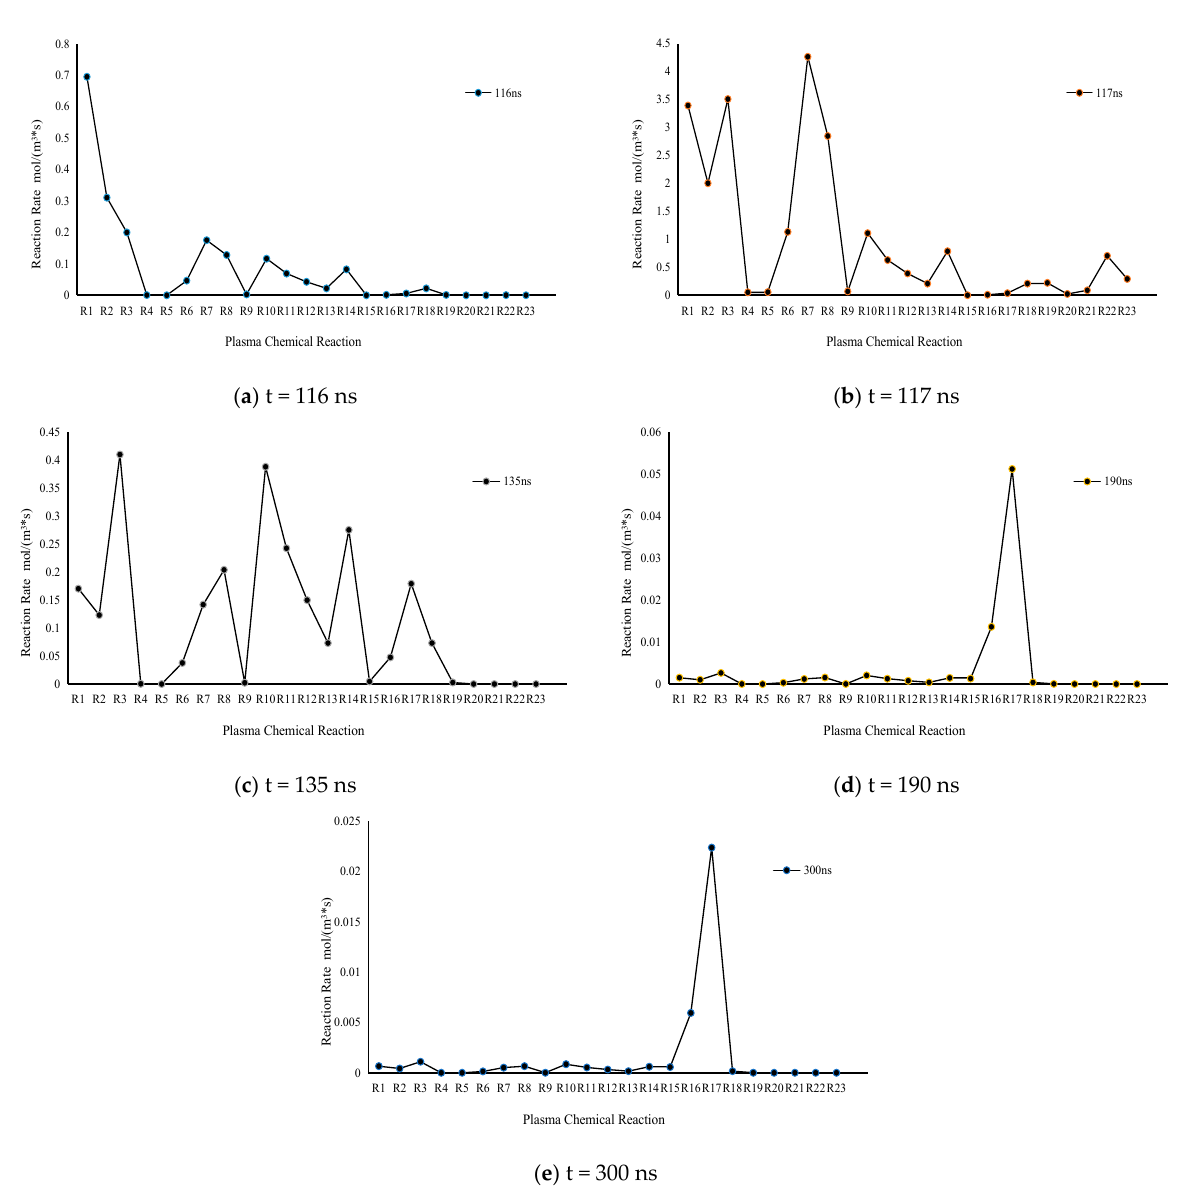
Figure 5. Reaction rate at five typical times.